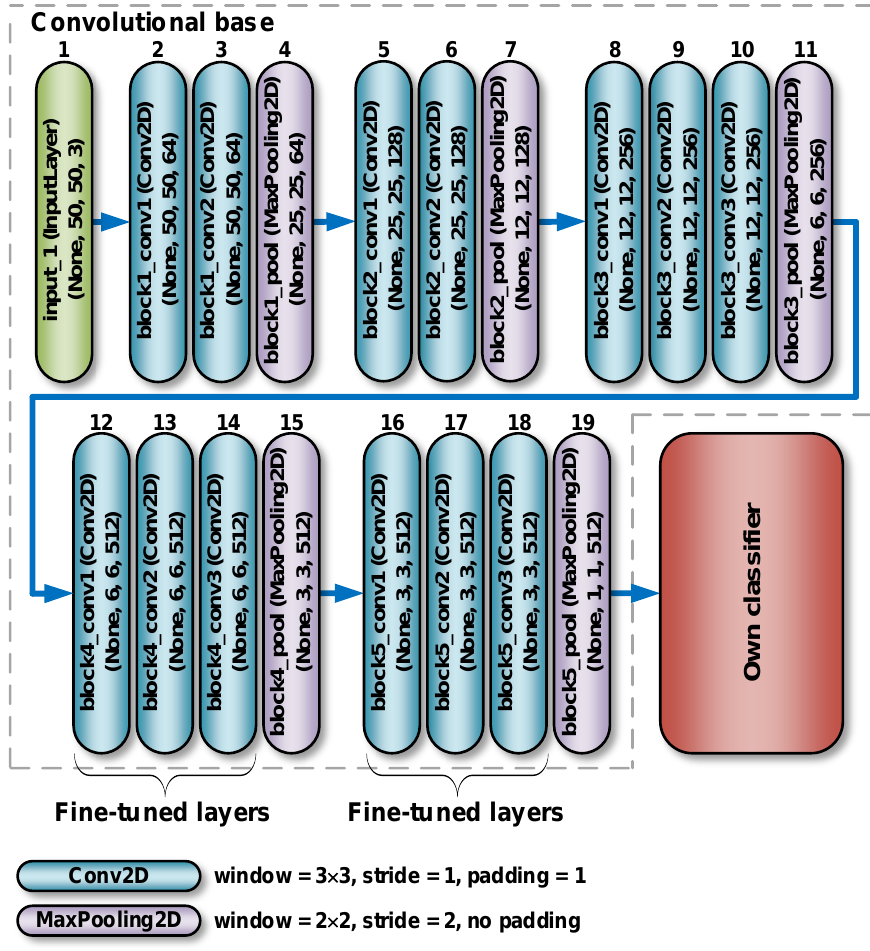
Figure 10. Structure of the VGG16 network.